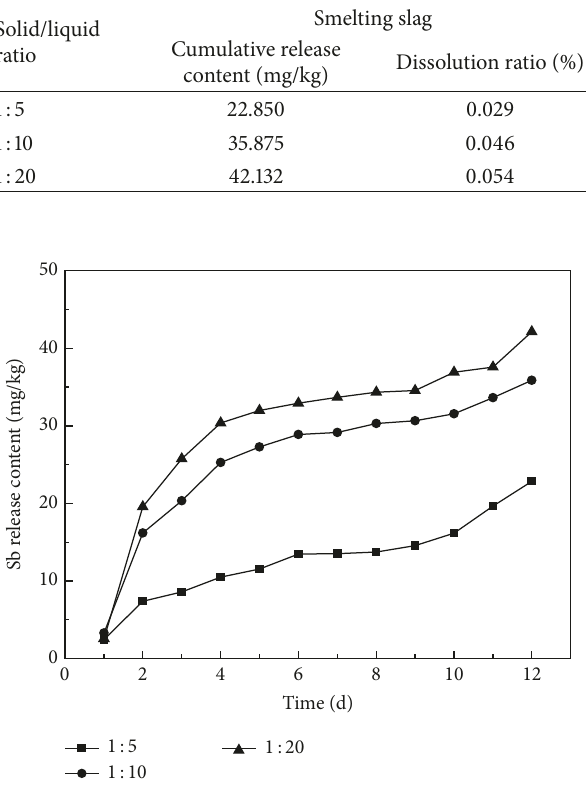
Figure 4: Sb release content per unit weight waste of smelting slag in static immersion